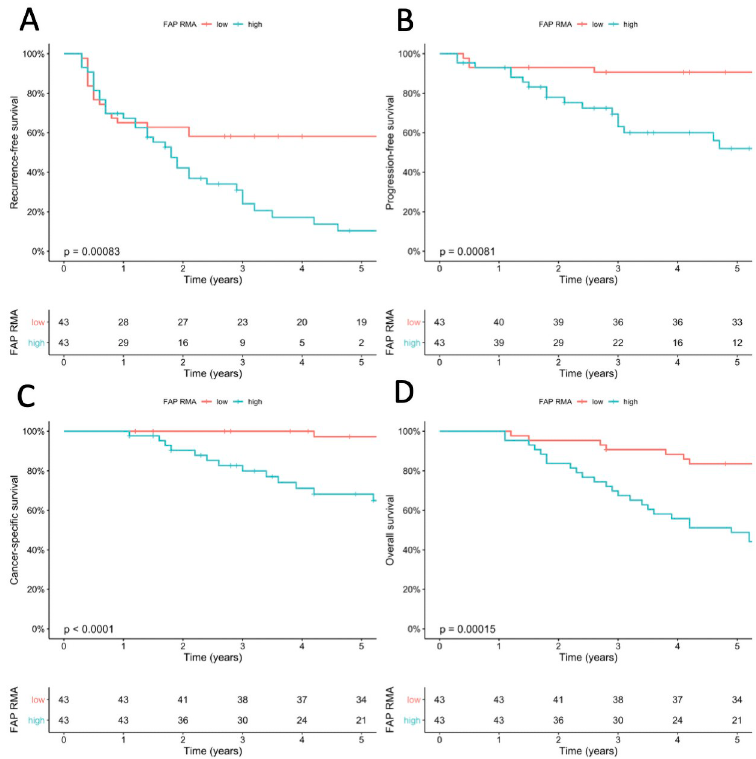
Fig 2. Kaplan-Meier plots of clinical outcome stratified by FAP expression as relative marker area (RMA) in HG T1 regions of interest (low [ � median] vs. high [ > median]). FAP expression stratified all patients (n = 86) significantly for each of the investigated clinical outcomes. A: Recurrence-free survival; B: Progression-free survival; C: Cancer-specific survival; D: Overall survival.